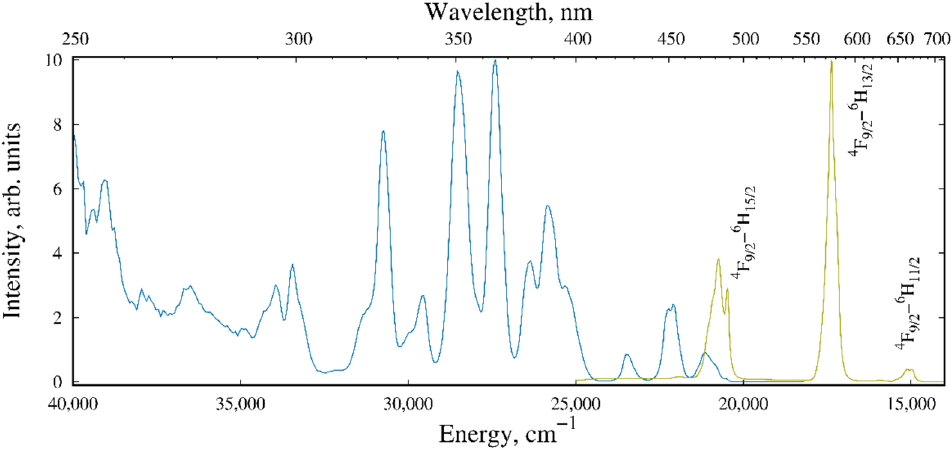
Figure 4. Excitation (blue line, λ em = 575 nm) and emission (yellow line, λ ex = 365 nm) spectra of 4 (solid sample, RT).